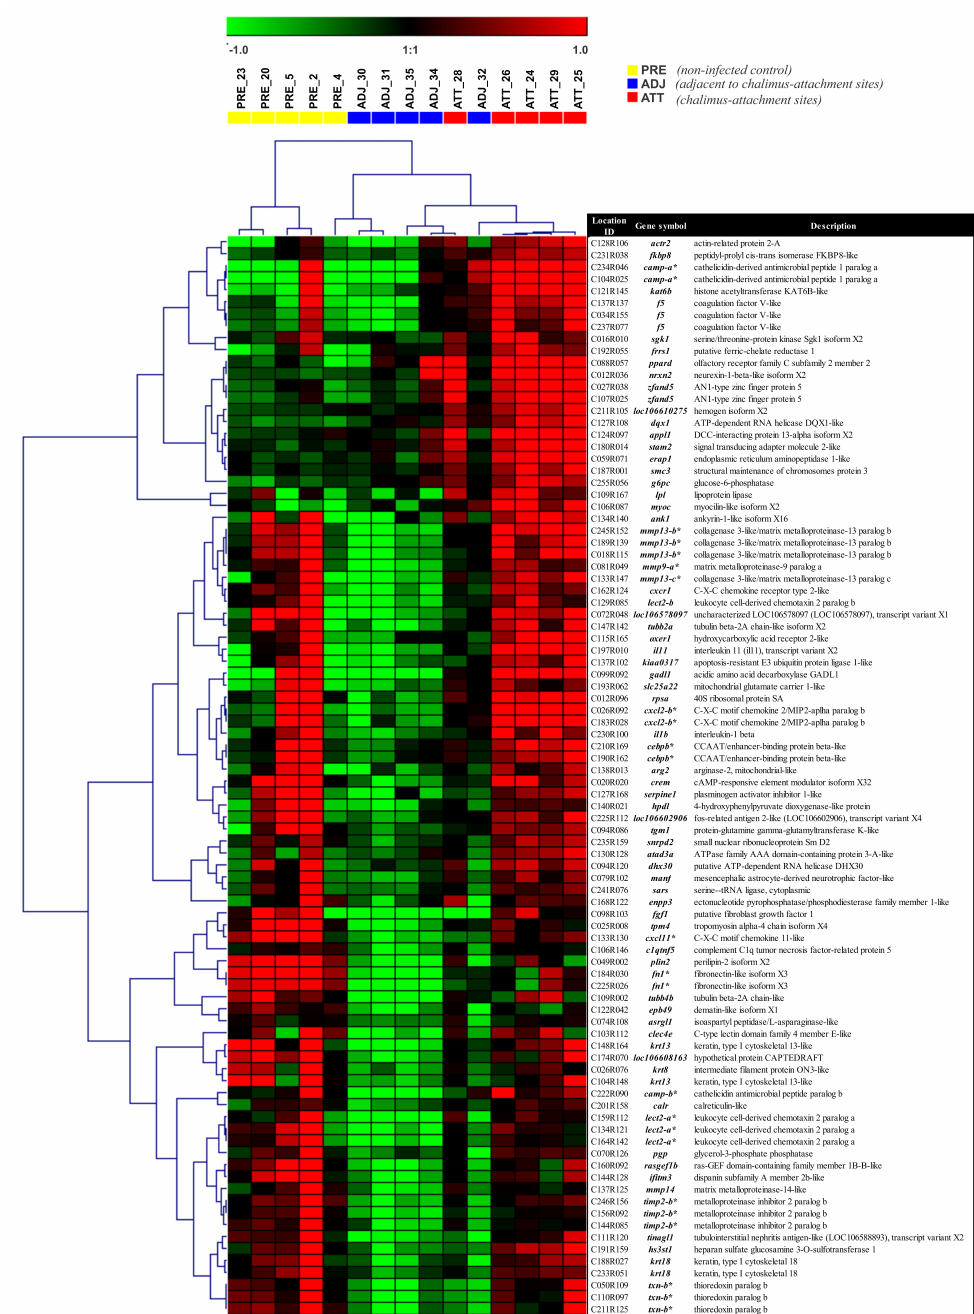
Figure 6. Heatmap illustration and hierarchical clustering analyses of DEPs between ATT and ADJ sites in Atlantic salmon fins across treatment groups. Clustering and heatmap results as an illustration of high-resolution figures are available in Supplementary Figure S6. Rows and columns represent the log 2 fold-change values of di ff erent transcript expression levels (90 DEPs) and individual fish from the lice-infection groups (colored boxes), respectively. Genes were median-centered and clustered using Pearson correlation and complete linkage hierarchical clustering. The colored boxes below the top legend represent individual fish from the lice-infection groups. *, transcripts that were QPCR-assayed. Substantial changes in the expression of genes encoding structural components of the cytoskeleton and ECM constituents were also observed (Table 1; Supplementary File S1). Genes encoding collagens (e.g., col10a1 , col6a1 , col15a1 ), actins (e.g., tpm1 ), tubulins (e.g., tuba4a , tubb ), fibronectin ( fn1 ),